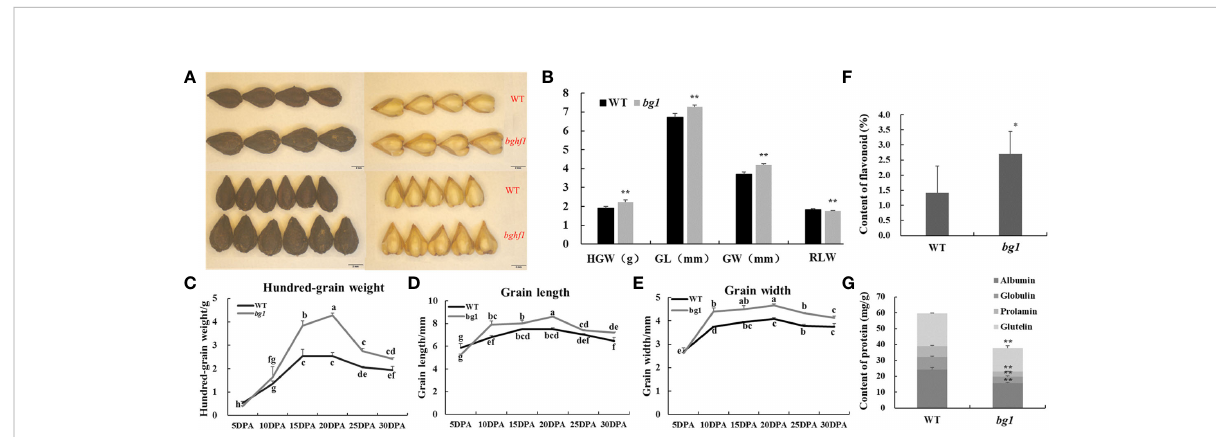
FIGURE 1 Morphological observations and statistical analysis of grain of WT and mutant bg1. (A) Morphological observations of grain at mature period. (B) Statistical analysis of grain traits at mature period. (C, D) Statistical analysis of grains at different development stages in WT and bg1 . (F, G) Statistical analysis of content of fl avonoid and storage protein components The scale bar = 2 mm in A. *P<0.05, **P<0.01. The same letter are not signi fi cantly different using multiple comparisons (P < 0.05) in (C – E)